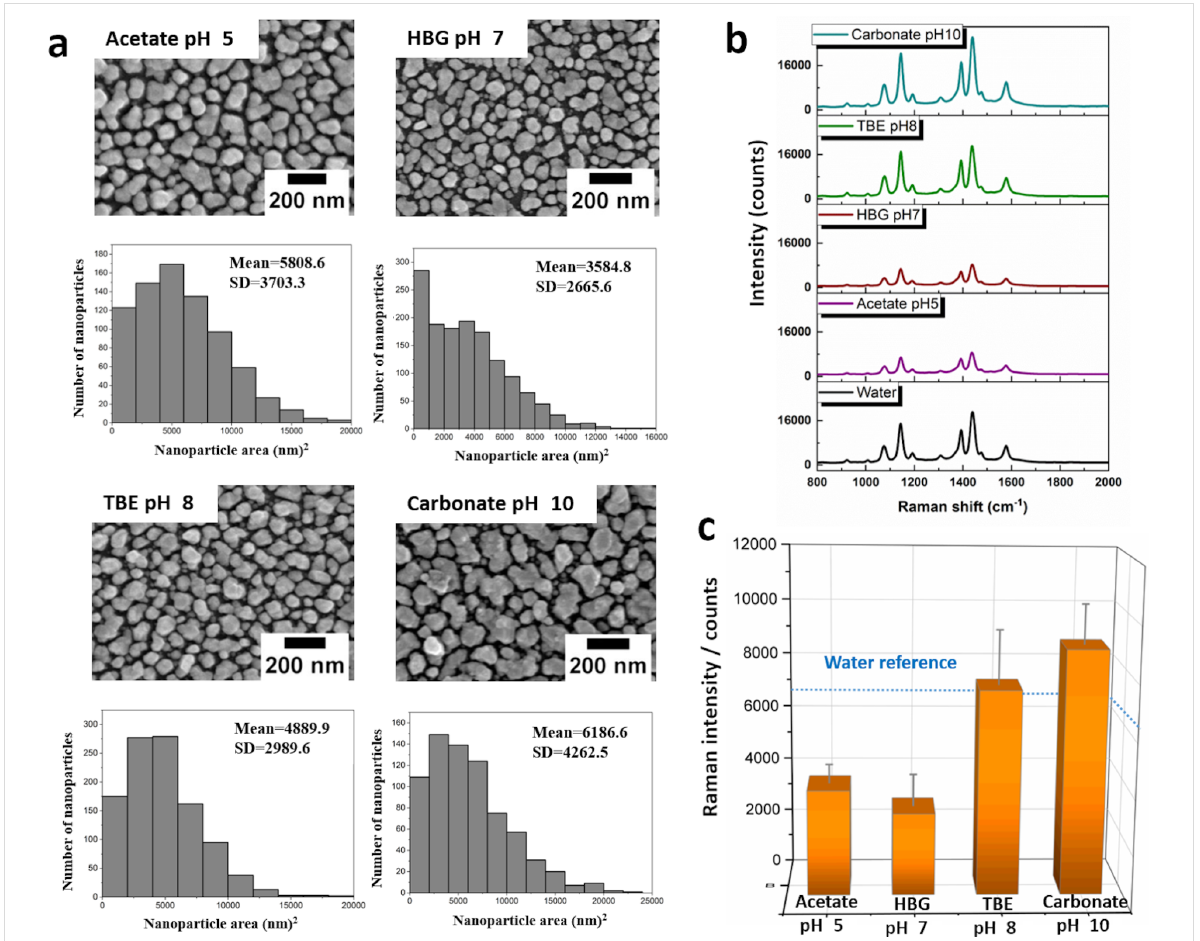
Figure 5: Stability test of microwave-fabricated SERS substrates for different buffer solutions with different pH values. (a) SEM images of Ag nanopar- ticle coatings after 1 h of immersion into different buffer solutions. (b) SERS spectra of a monolayer of 4-ATP. The spectrum obtained after water treatment serves as a reference. (c) Error analysis of the 1078 cm − 1 marker peak which is attributed to the electromagnetic field enhancement mecha- nism [29]. The blue dotted line marks the Raman intensity level obtained for 1 h of water